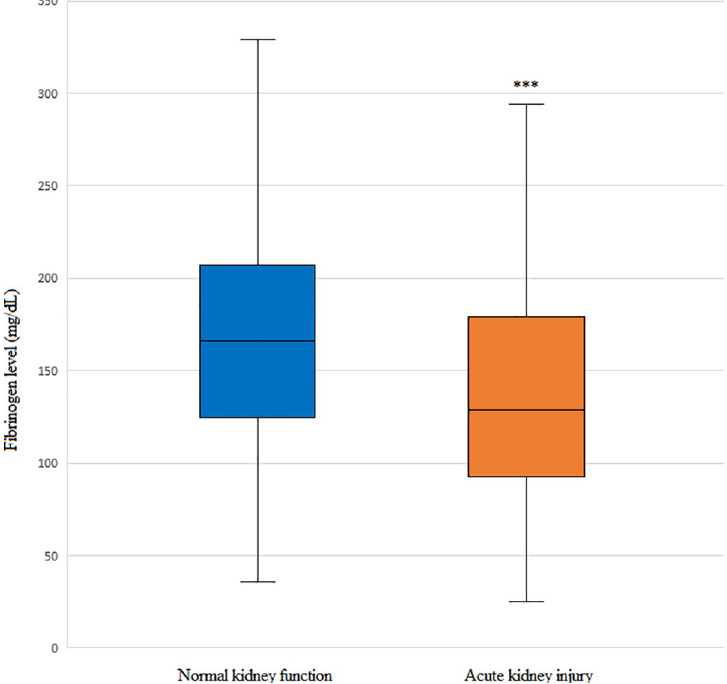
Fig 1. Comparison of serum fibrinogen levels according to the development of acute kidney injury (AKI) in patients who underwent living donor liver transplantation (LDLT). The box plots show the median (line in the middle of the box), interquartile range (box), and 5 th and 95 th percentiles (whiskers). ��� p < 0.001 vs. normal kidney function.